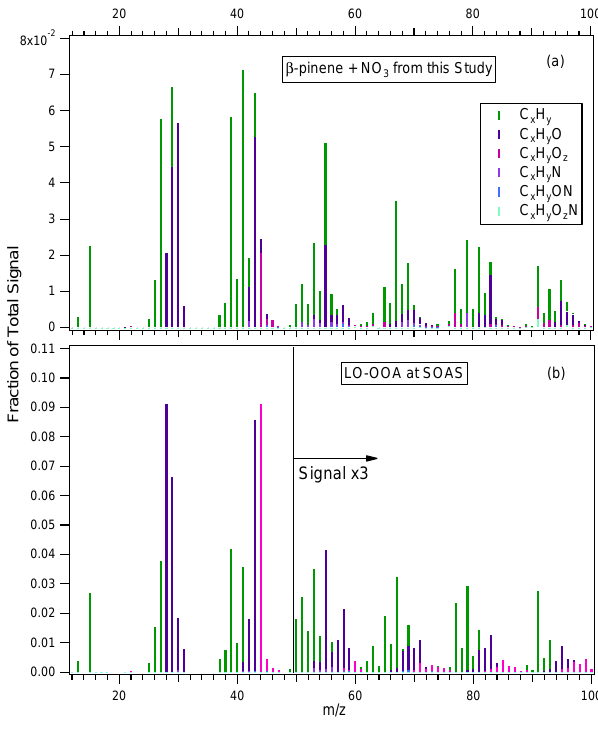
Figure 10. A comparison of mass spectra obtained from this work and the LO-OOA factor identified from PMF analysis of the HR- ToF-AMS data from the SOAS field campaign. (a) Mass spectrum of the SOA formed from the β -pinene + NO 3 reaction at RH = 70 % under “RO 2 + HO 2 dominant” conditions and (NH 4 ) 2 SO 4 + H 2 SO 4 seed (Experiment 34 in Table 1). (b) Mass spectrum for the LO- OOA factor identified from PMF analysis of the SOAS HR-ToF- AMS data (Xu et al., 2015b). The mass spectra are colored by the ion type to indicate their contribution to the mass spectra. Ions C 5 H + ( m/z 67) and C 7 H + ( m/z 91) are distinctive for the β -pinene 7 7 mass spectrum (Sect. 5 of main text). To facilitate comparison, m/z > 50 have been multiplied by a factor of 3 in the LO-OOA